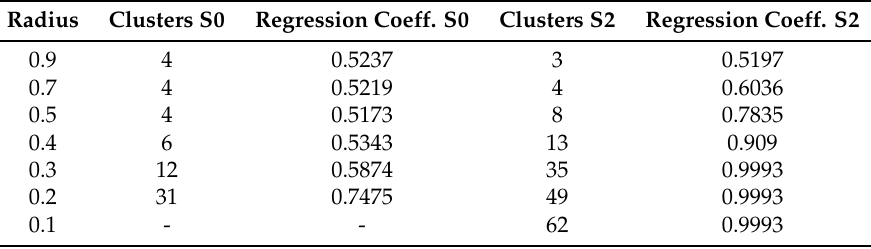
Table 6. Comparison table of Takagi–Sugeno